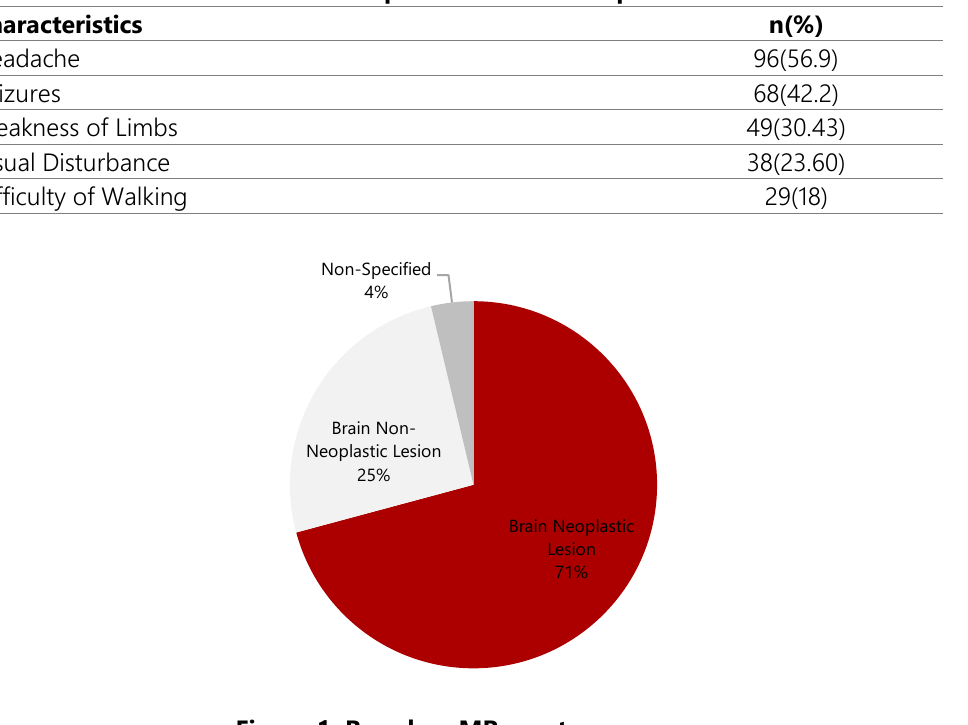
Figure 1: Based on MR spectroscopy.